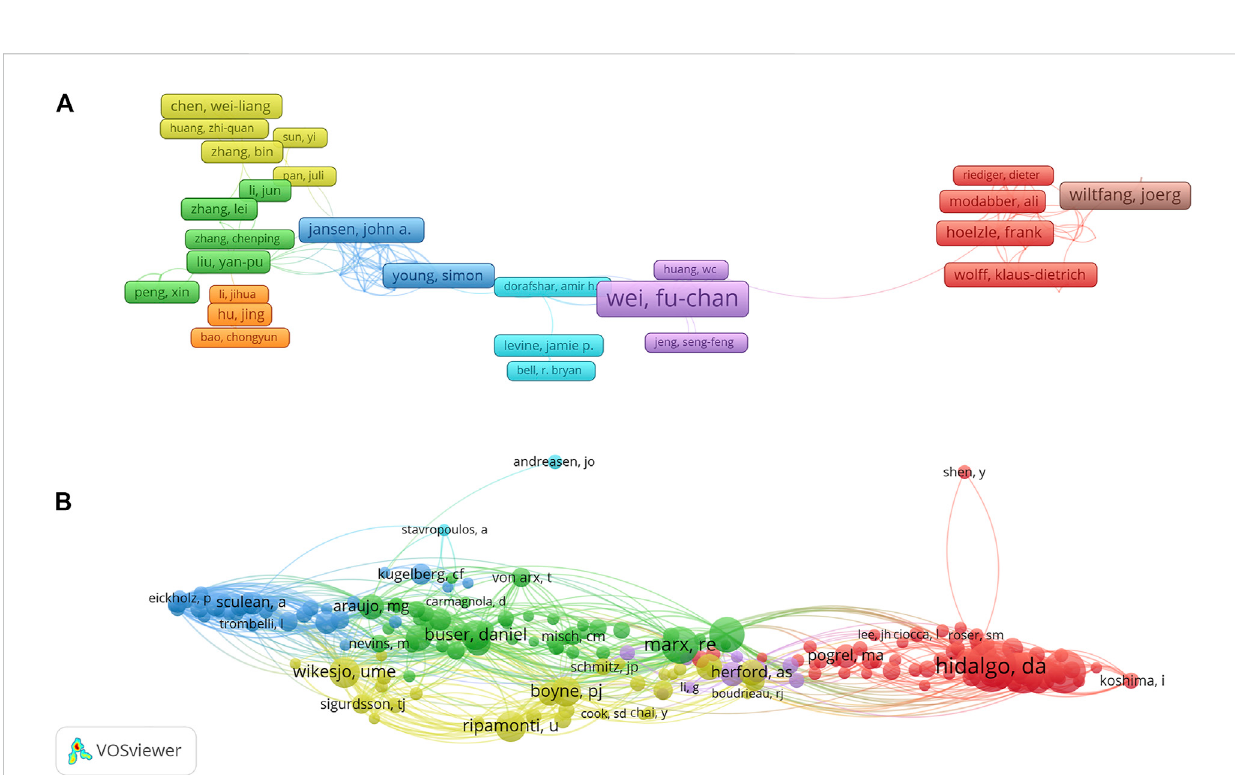
FIGURE 5 VOSviewervisualizationmapofauthorsandco-citedauthorsdevotedtomandibulardefectresearch. (A) Cooperationnetworkofauthors.Ofthe18, 209 authors, 183 had published at least six documents. (B) Co-citation network of authors. Of the 46,363 co-cited authors, 200 had at least 50 citations.